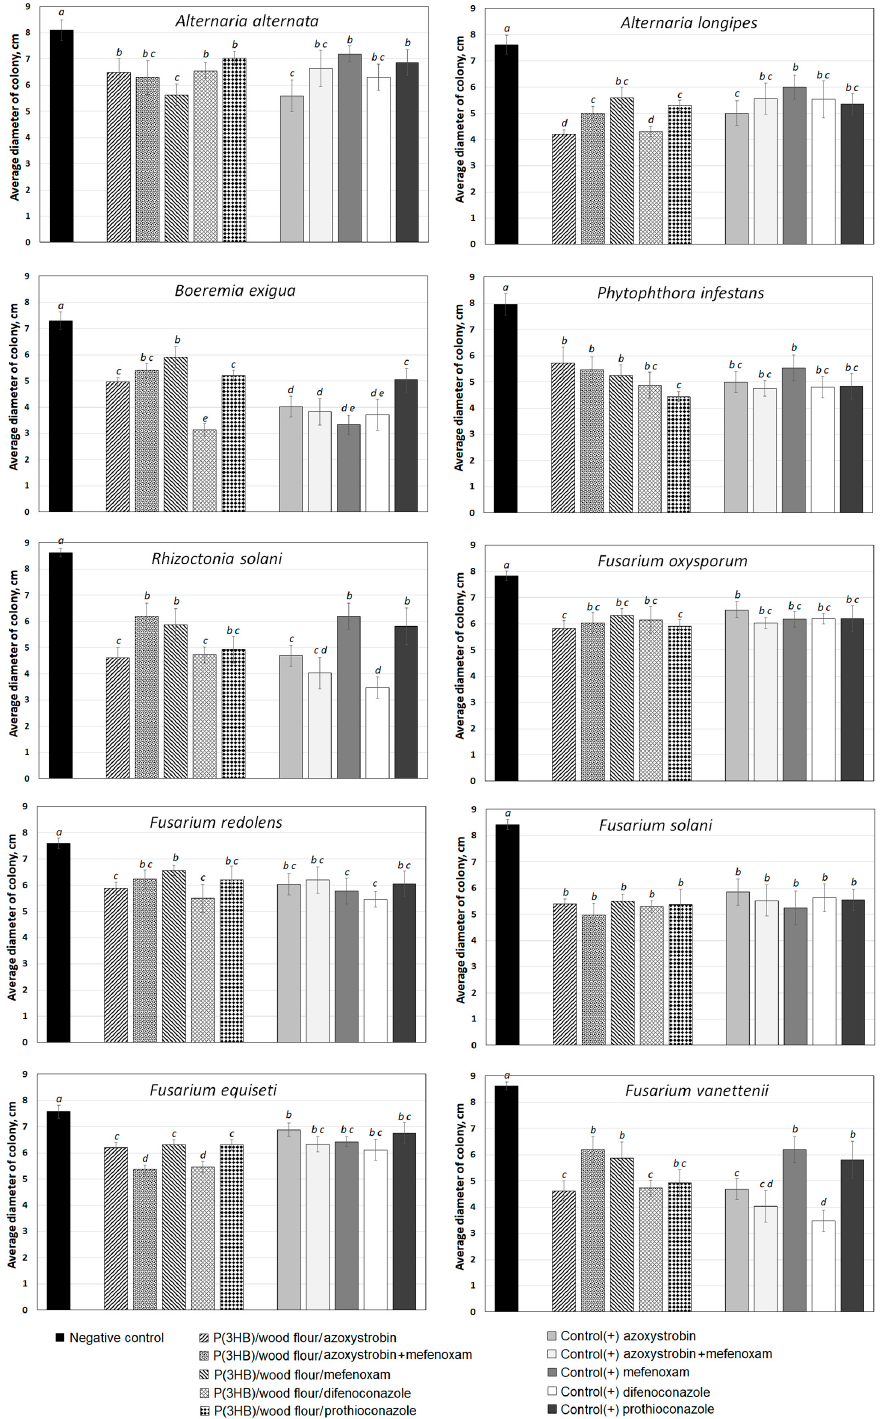
Figure 10. Diameters of the colonies of phytopathogenic fungi affected by different (embedded and free) forms of fungicides. The letters indicate the significance of differences when comparing groups according to the Mann–Whitney test at the level of p < 0.05; identical letters indicate no significant differences.